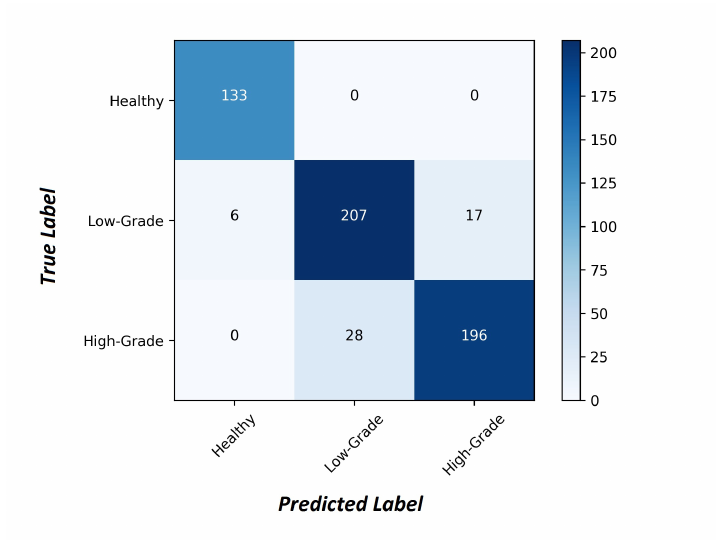
Figure 7. Confusion matrix with labels.